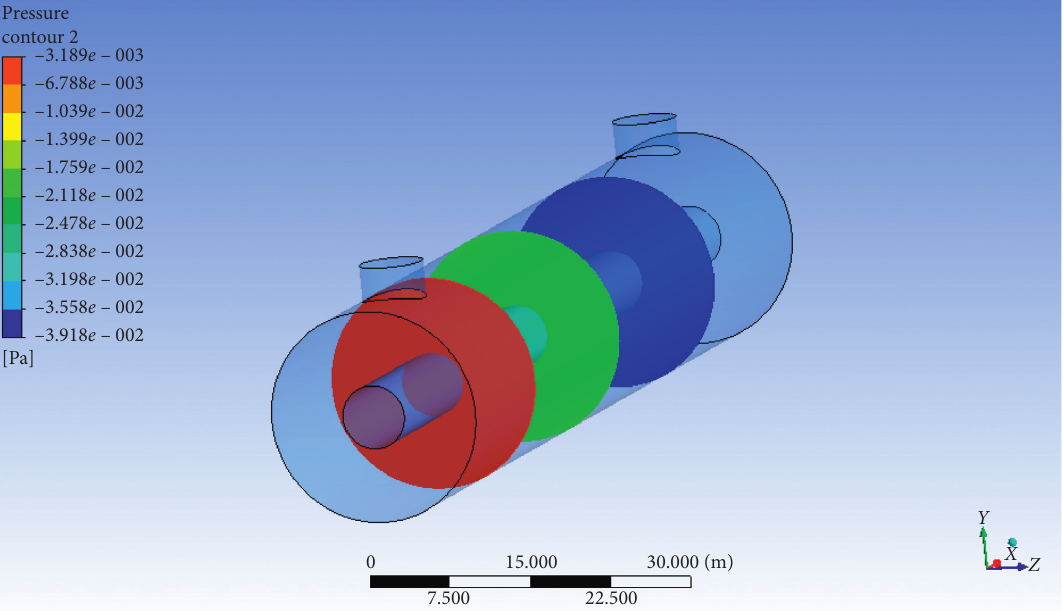
Figure 10: Model different position processing average pressure maps.